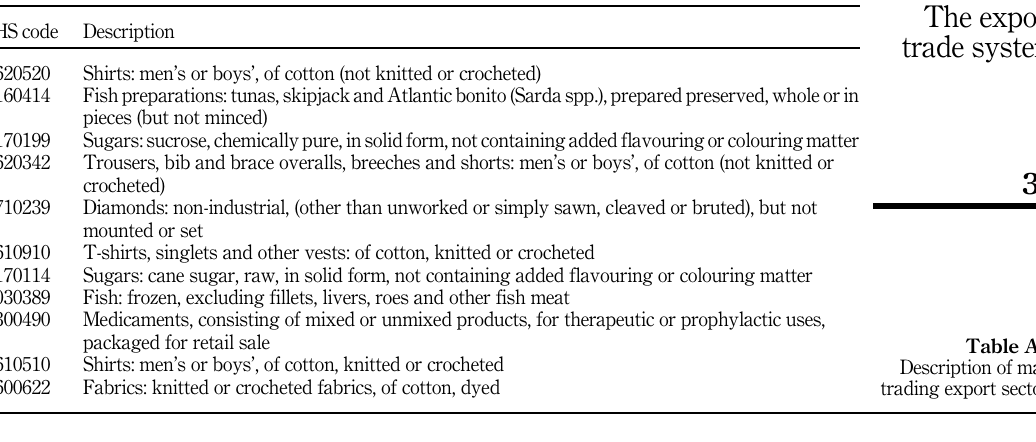
Table A1. Description of main